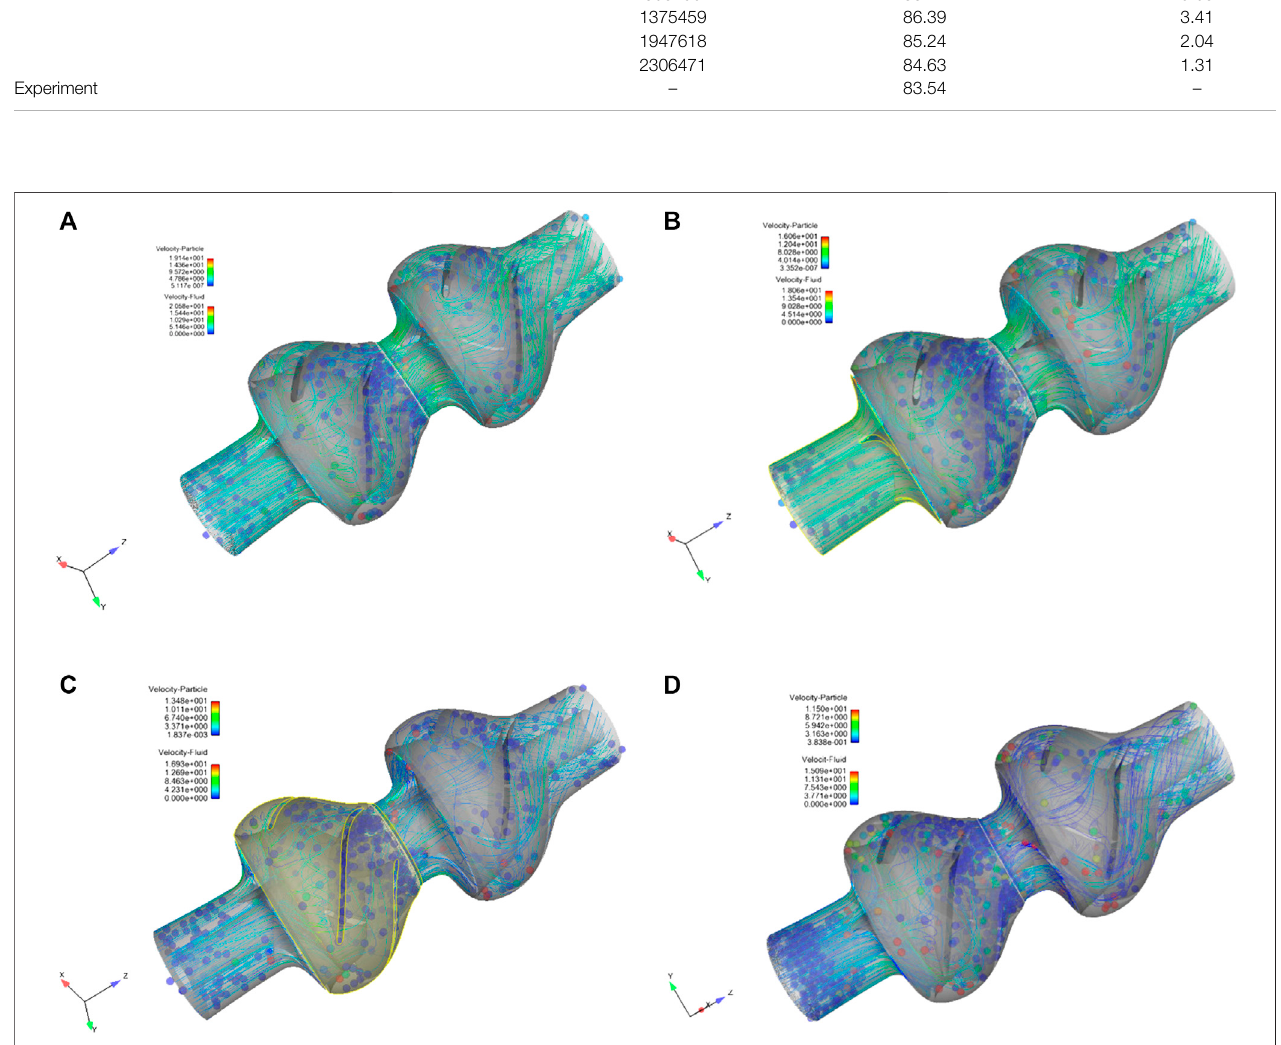
Frontiers in Energy Research |